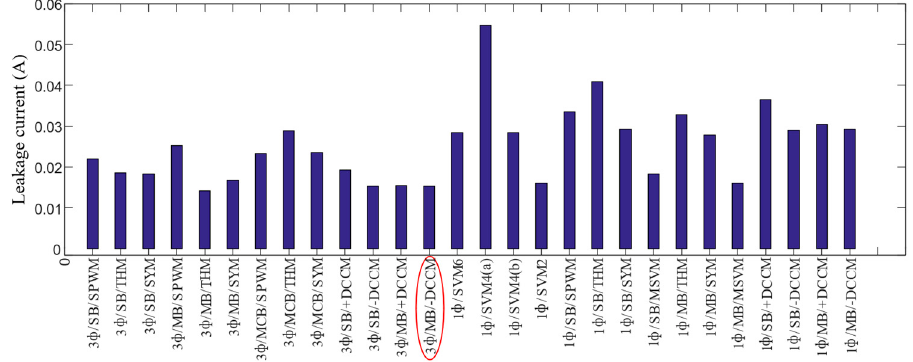
Figure 15. Leakage current values of all modulation schemes at V ph = 220 V.